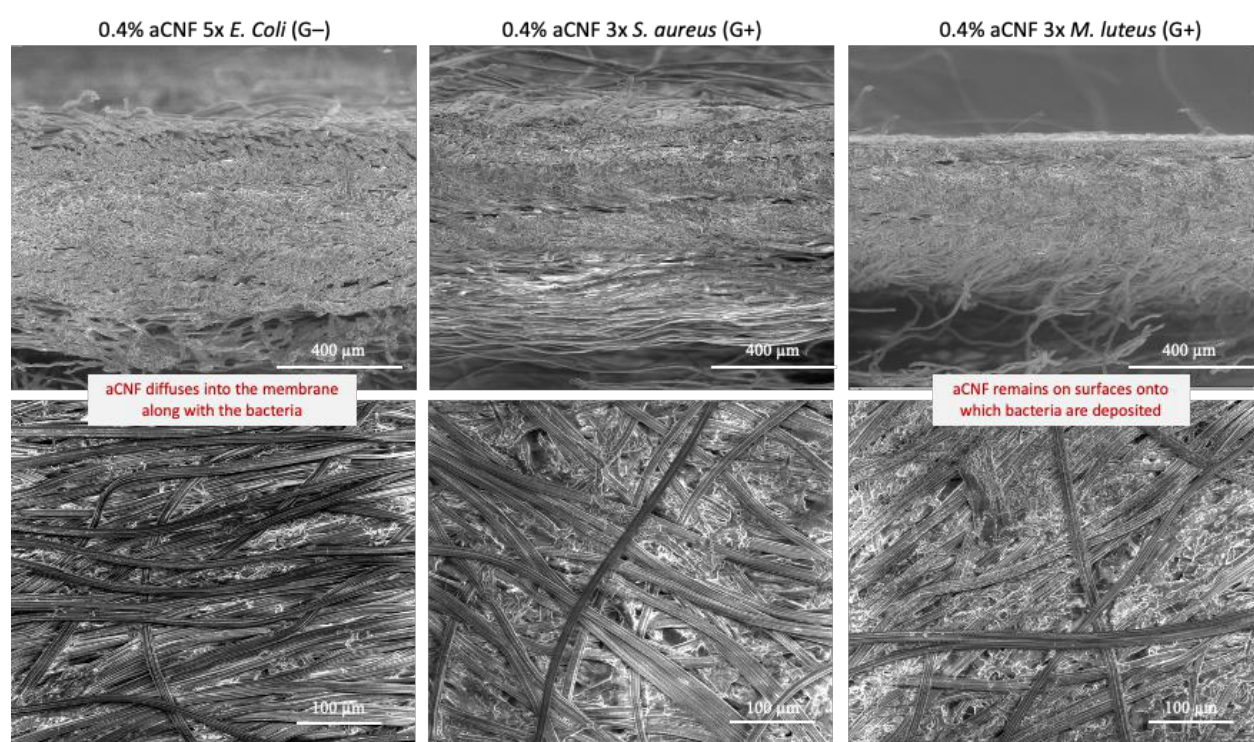
Figure 7. SEM micrographs for cross section ( top ) and surface ( bottom ) of an individual (single- layered) fibrous membrane (impregnated with 0.4 wt% of amino-hydrophobised CNF/aCNF, pre- suspended in 0.1 wt% quaternised cellulose nanofibrils/qCNF) after multi-filtration cycles of bacterial suspensions, performed with vacuum filtration at a pressure of 0.6 bar and room temperature. The results are in good agreement with other similar studies performing using CNF.